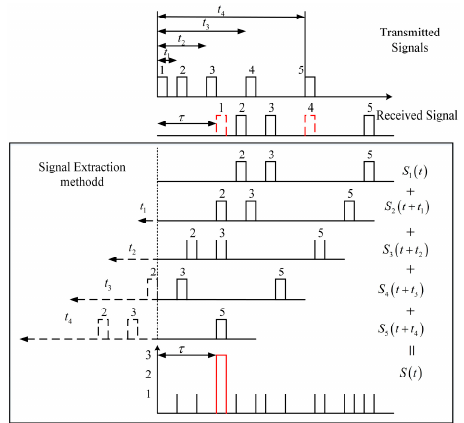
Figure 2. Shift pulse accumulation method.